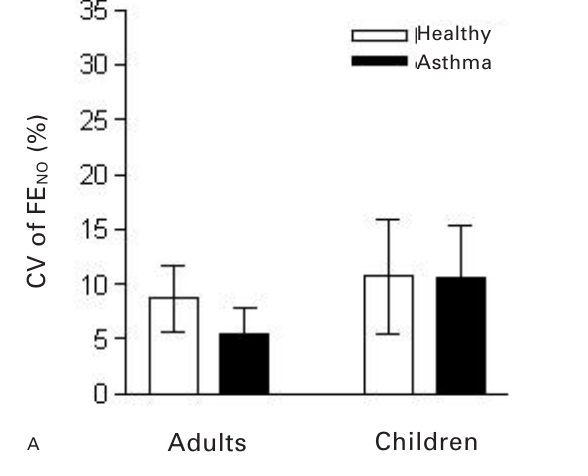
Repeatability of FE NO (Panel A) and nasal NO (Panel B) mea- surements. Data are coefficient of varia- tion (CV, %)